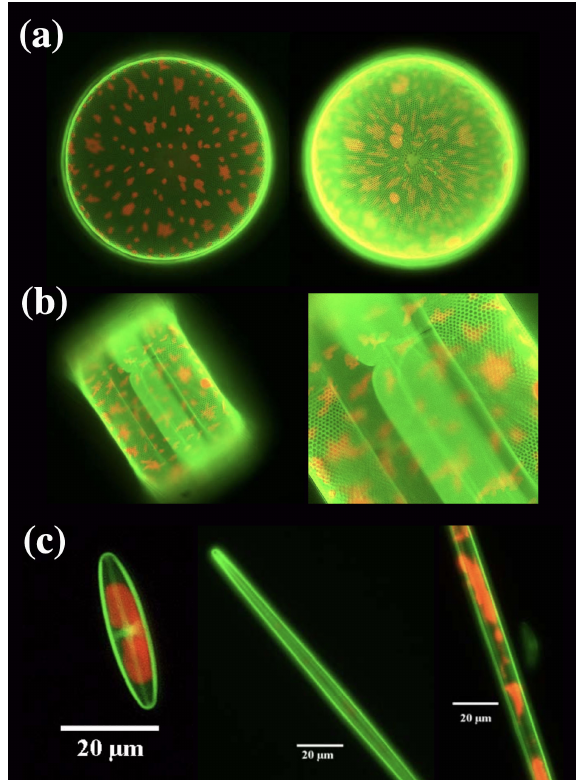
Figure 4. ( a ) Fluorescence of a living Coscinodiscus wailesii diatom grown in 1 µ M ( left ) and 10 µ M ( right ) concentration of Rh 19. Red autofluorescence of choloroplasts is also visible. Valve diameter (cid:39) 220 µ M. ( b ) Lateral view ( left ) and relative detail ( right ) of a living C. wailesii diatom cell after several division cycles. The frustule as a whole results fluorescent (both techae are stained). Diameter of the valve (cid:39) 200 µ M. ( c ) Examples of pennate freshwater diatoms grown in a Rh 19 doped culture medium. ( a ) reproduced with permission from [47]. ( b , c ) reproduced with permission from